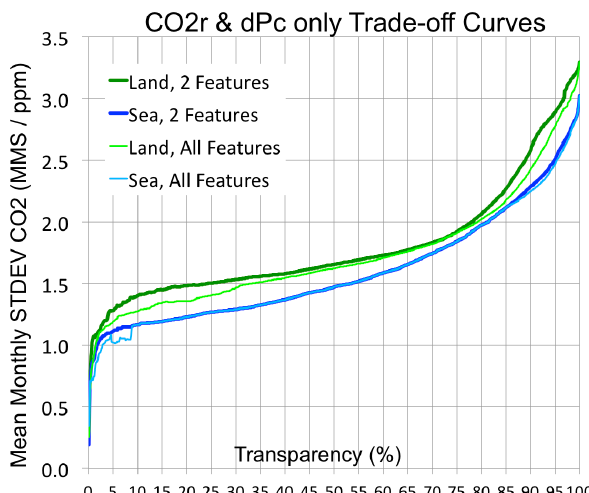
Figure 10. Using only the two chosen features CO2 ratio (CO2r) and Delta Pressure Cloud 2 Fig. 10. Using only the two chosen features CO 2 ratio (CO2r) (dPc), the complexity=2 filters for land and sea are re-derived. Performance of the new 2-3 and Delta Pressure Cloud (dPc), the complexity = 2 filters for land feature trade-off curves is similar to those using all-features, proving our feature selection was 4 and sea are re-derived. Performance of the new 2-feature trade-off successful. The small dip observed in the “Sea, All Features” curve near 5% transparency is 5 curves is similar to those using all-features, proving our feature se- merely a sub-region where the cross-track sounding angle paired with CO2r was slightly more 6 lection was successful. The small dip observed in the “Sea, All Fea- efficient than dPc plus CO2r. 7 tures” curve near 5% transparency is merely a subregion where the cross-track sounding angle paired with CO2r was slightly more ef- ficient than dPc plus CO2r.